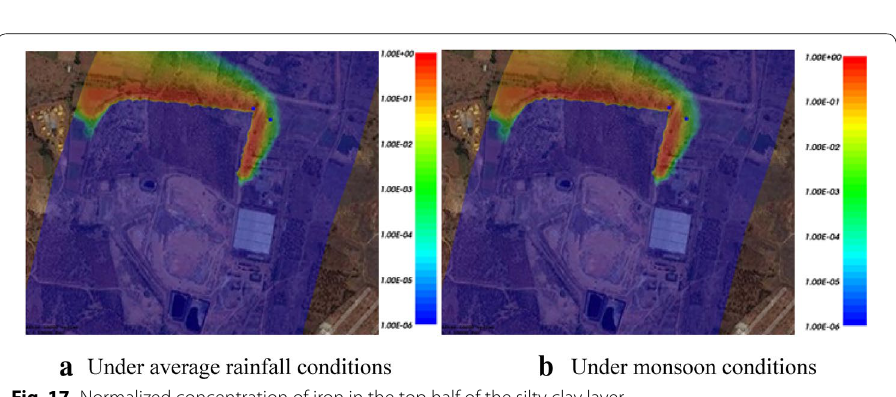
Fig. 17 Normalized concentration of iron in the top half of the silty clay